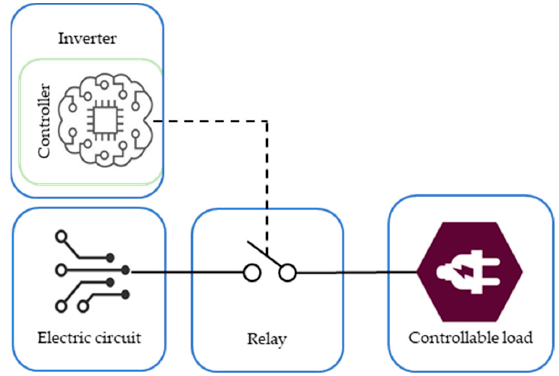
Figure 2. The control scheme for the demand response (DR) cut with one load.